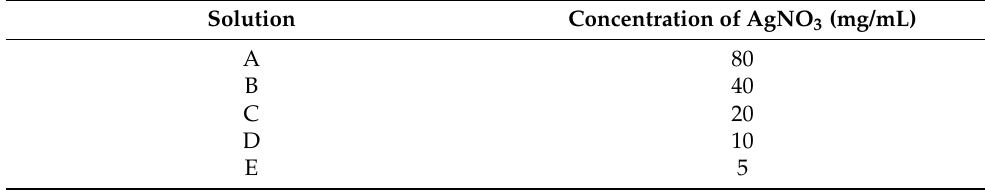
Table 3. Concentrations of the AgNO 3 solutions used in the preparation of the AgNP-loaded hydrogels.